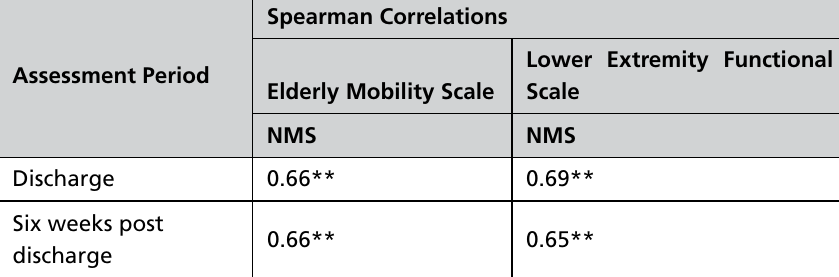
table 3: Pre-fracture functional level and post-operative functional out- come